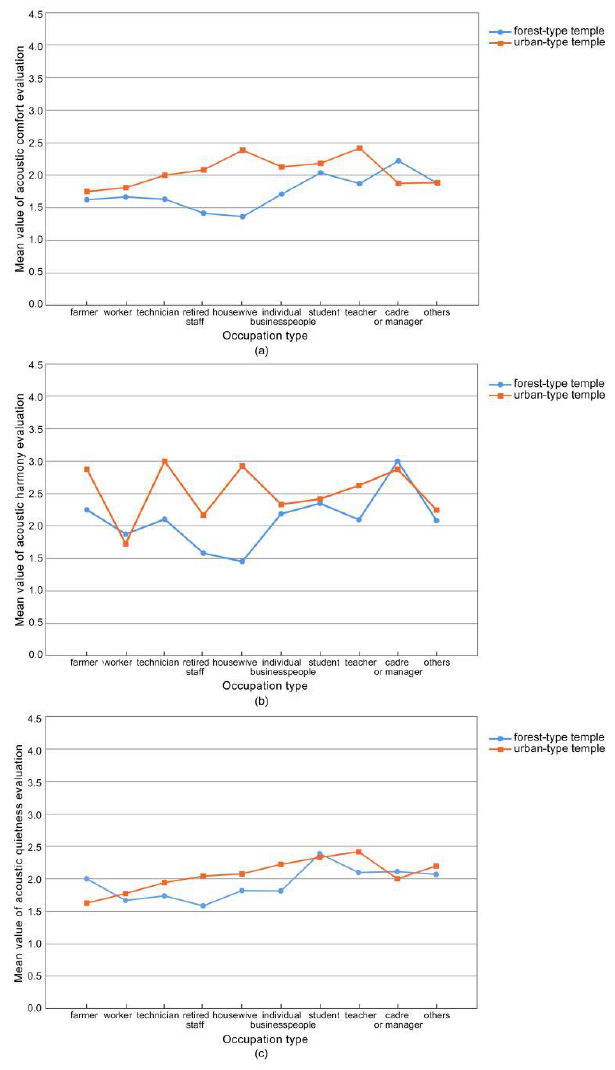
Figure 8. The evaluation value of the acoustic environment by different respondents’ occupations: ( a ) comfort; ( b ) harmony; ( c ) quietness.